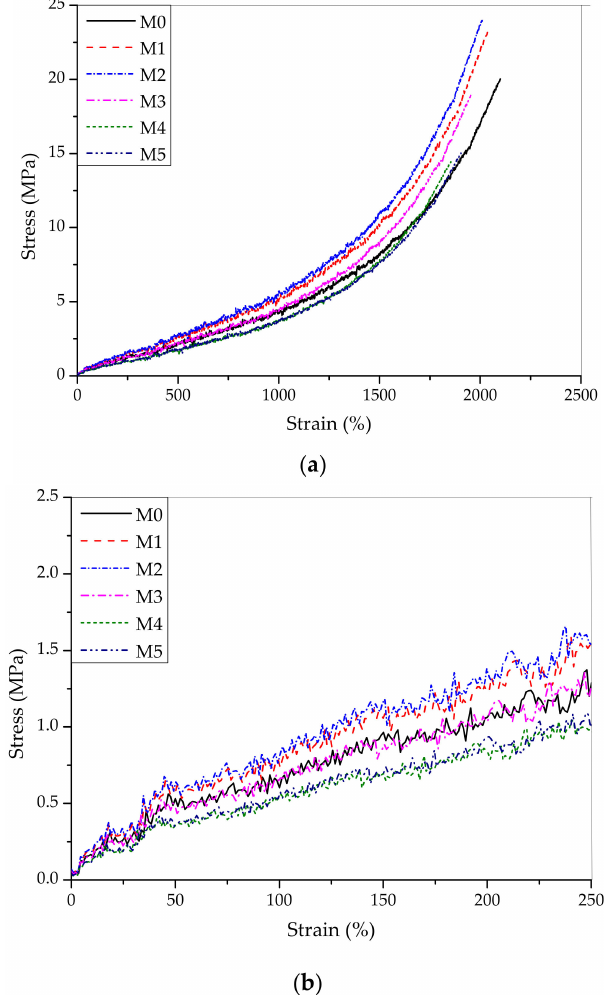
Figure 6. ( a ) Typical stress-strain of cured samples (Black line—M0; red line–M1; blue line—M2; pink line—M3; olive line—M4; orange line—M5). ( b ) The bottom figure is the one expanded in the initial